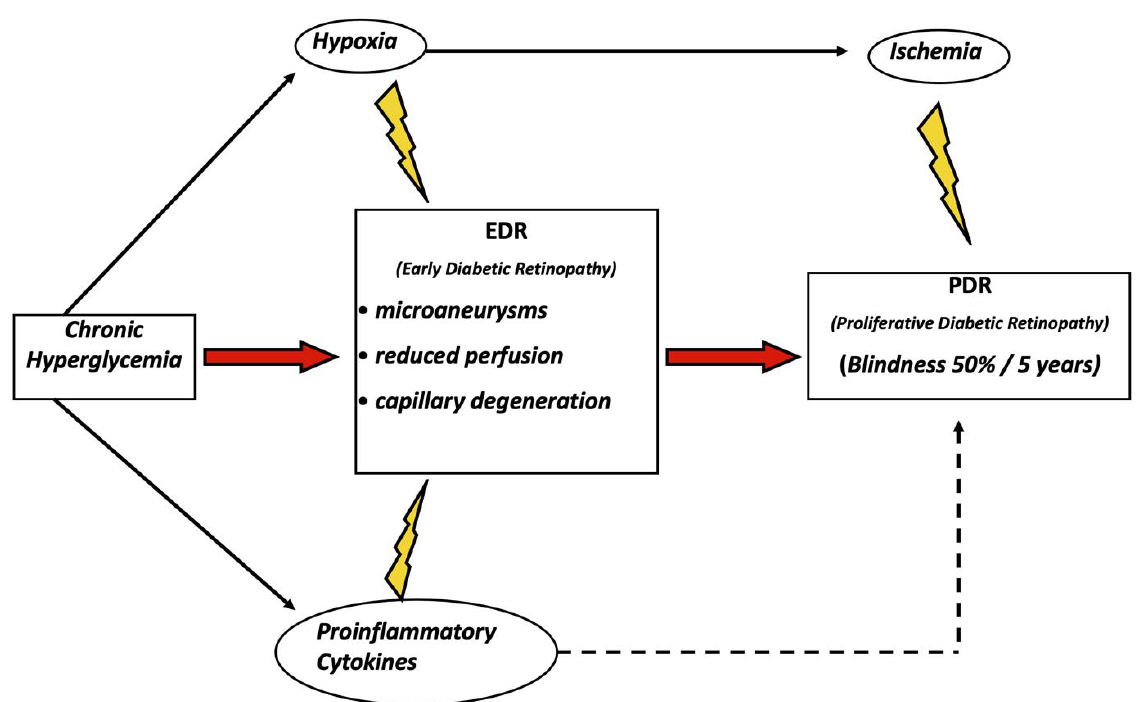
Figure 1. Schematic rendition of the main causative events in the pathogenesis of diabetic retinopathy.